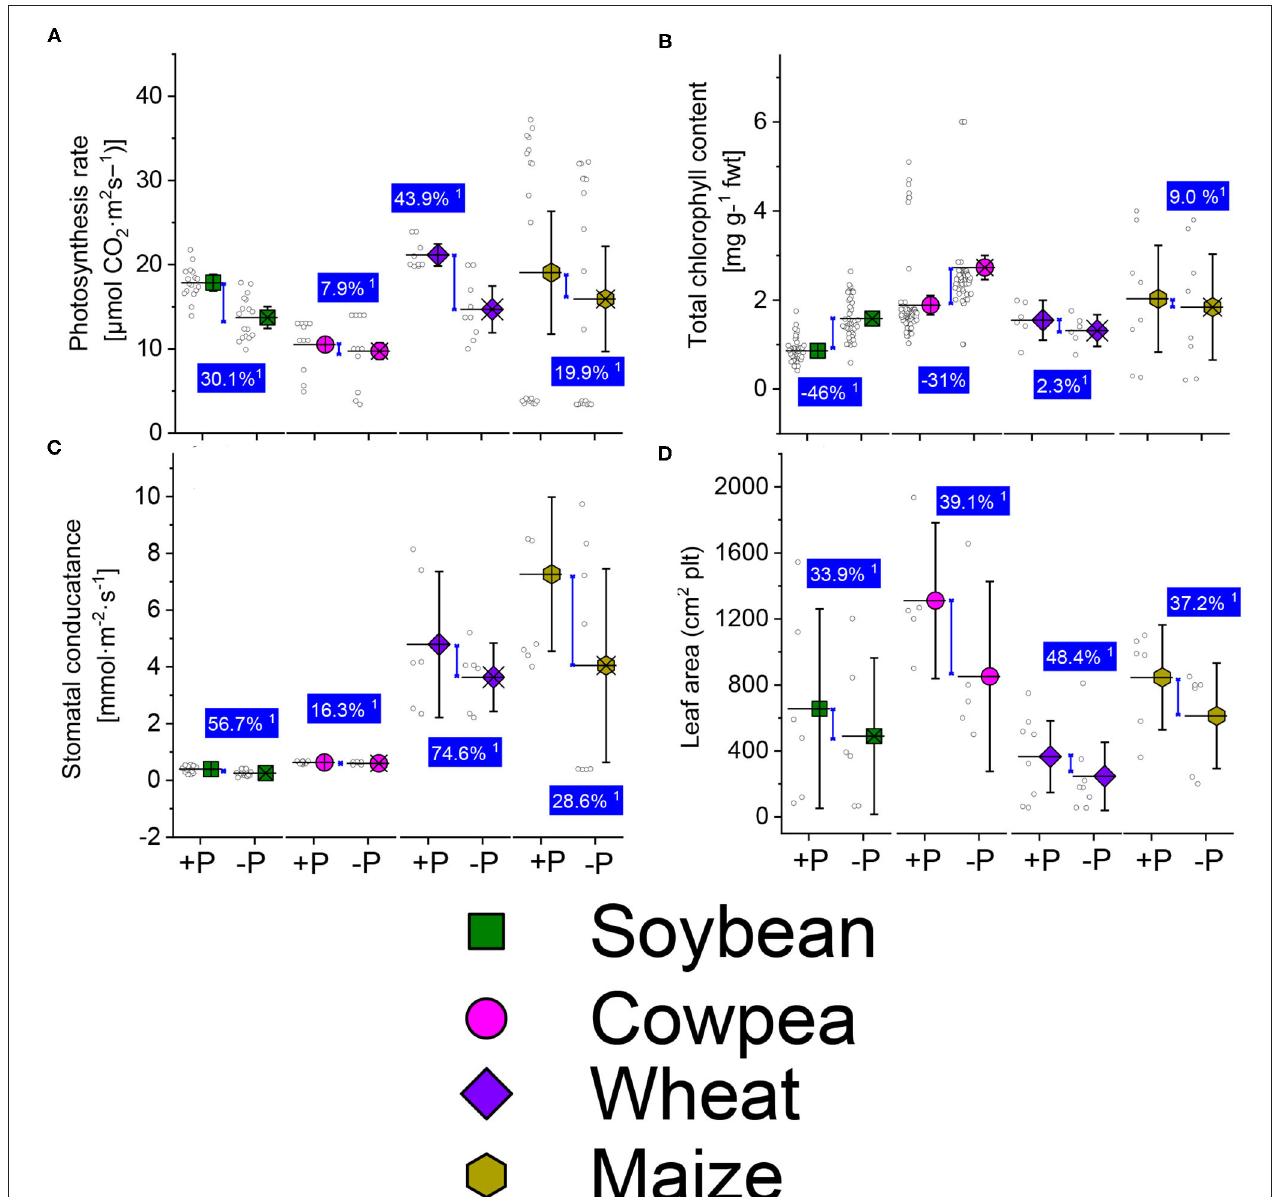
FIGURE 1 | Boxplots and scatter data of the photosynthesis rate (A) total chlorophyll content (B) stomatal conductance (C) leaf area (D) under sufficient-P ( + P), and deficient (–P) conditions of soybean, cowpea, wheat, and maize plants. 1 Average change (%) of + P applied over P-deficient plants. Means + bootstrap at 95% CIs of two tested P treatments that do not overlap indicate a significant relative increase